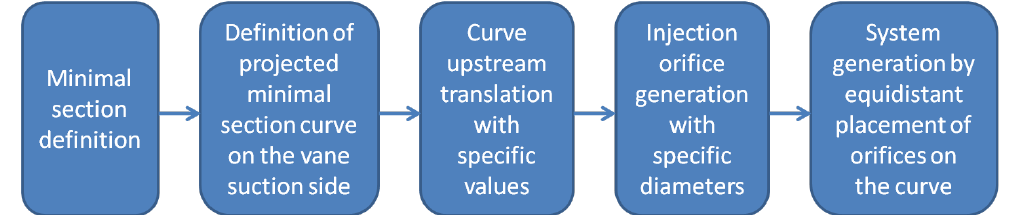
Figure 3. Steps for injection model generation. Table 2. Numerical grid analysis results.